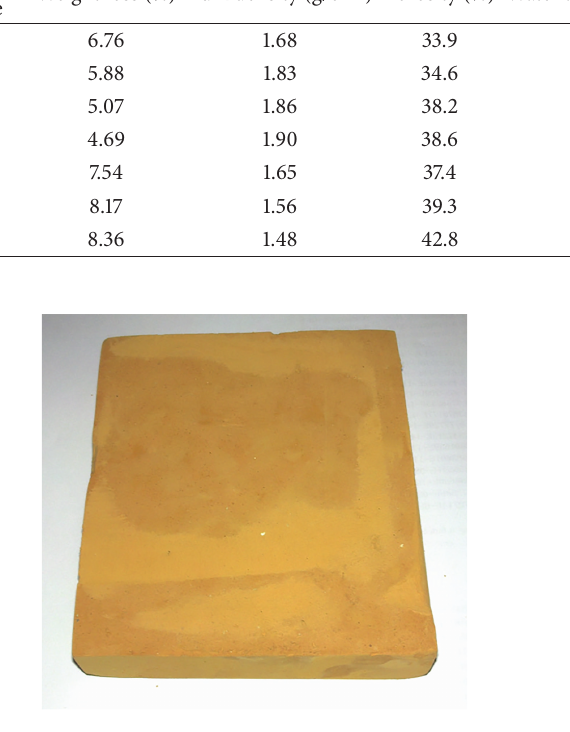
Figure 1: Produced brick sample.